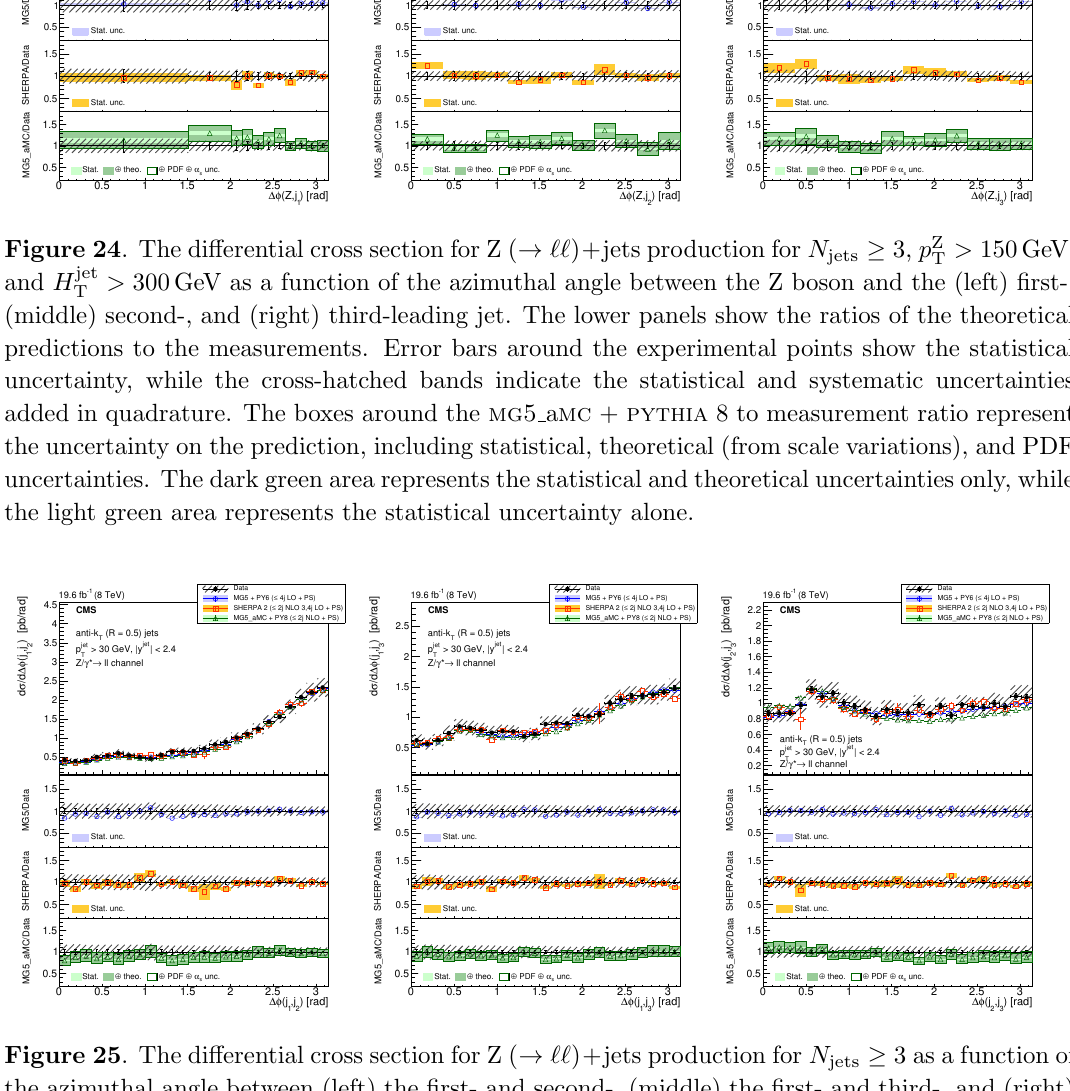
Figure 25 . The di(cid:11)erential cross section for Z ( ! ‘‘ )+jets production for N jets (cid:21) 3 as a function of the azimuthal angle between (left) the (cid:12)rst- and second-, (middle) the (cid:12)rst- and third-, and (right) the second- and third-leading jets. The lower panels show the ratios of the theoretical predictions to the measurements. Error bars around the experimental points show the statistical uncertainty, while the cross-hatched bands indicate the statistical and systematic uncertainties added in quadrature. The boxes around the mg5 a mc + pythia 8 to measurement ratio represent the uncertainty on the prediction, including statistical, theoretical (from scale variations), and PDF uncertainties. The dark green area represents the statistical and theoretical uncertainties only, while the light green area represents the statistical uncertainty alone.